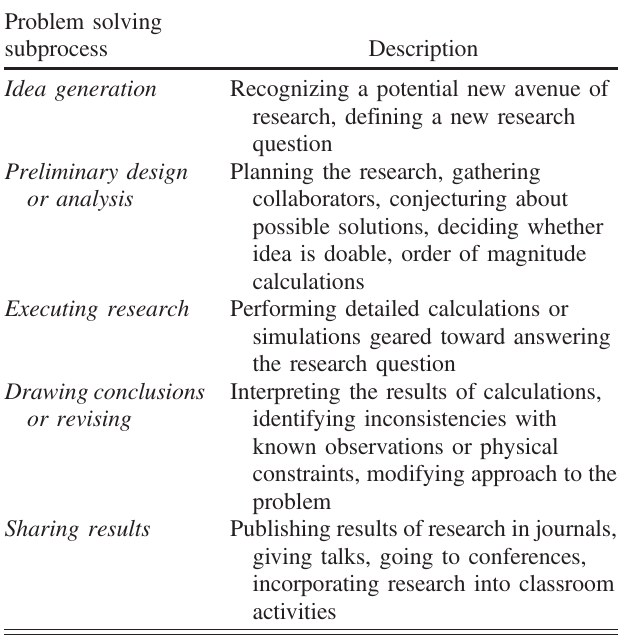
TABLE III. Code descriptions generated to identify the approxi- mate subprocesses involved in theorists ’ overall problem-solving processes. Subprocesses were identified independently and were found to largely agree with prior results in Ref.